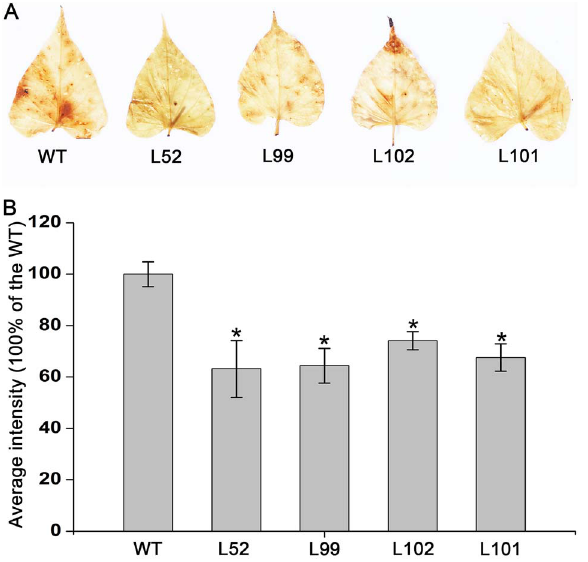
Fig. 10. Effects of salt stress on H 2 O 2 accumulation in the IbMas -overexpressing sweetpotato plants. (A) Accumulation of H 2 O 2 in the leaves of salt-tolerant transgenic plants (L52, L99, L102 and L101) and wild- type plant (WT). A plant grown in a 19-cm diameter pot was irrigated with a 200 mL of 200 mM NaCl solution once every 2 days for 2 weeks. (B) The average intensity of DAB staining leaves after converting to 256 grey scale images. Data are presented as means ¡ SE (n 5 3). * and ** indicate a significant difference from that of WT at P , 0.05 and , 0.01, respectively, by Student’s t -test.